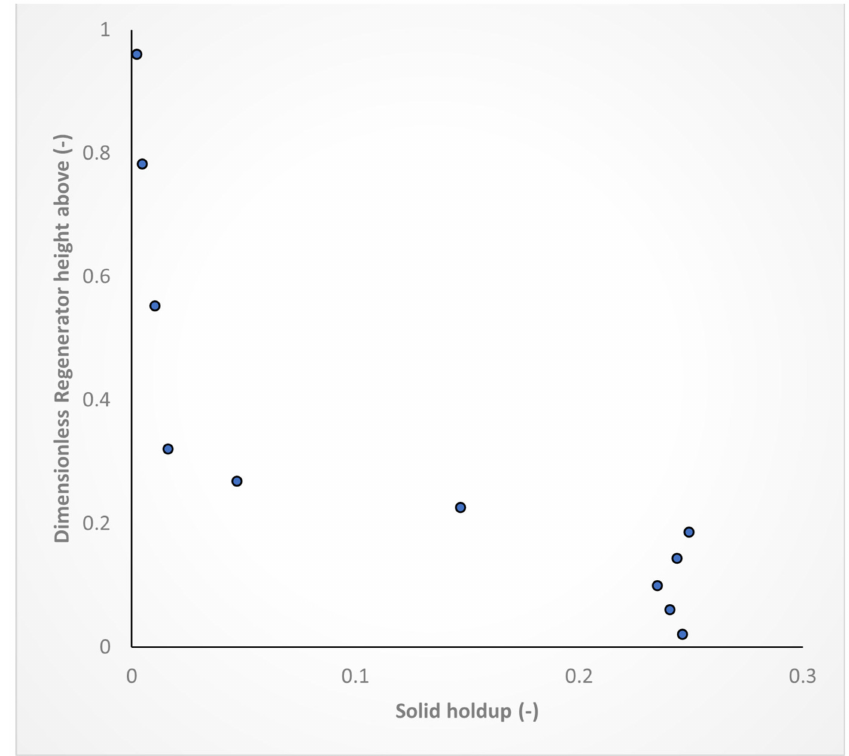
Figure 1. Axial solid profile in FCC regenerator (redrawn from